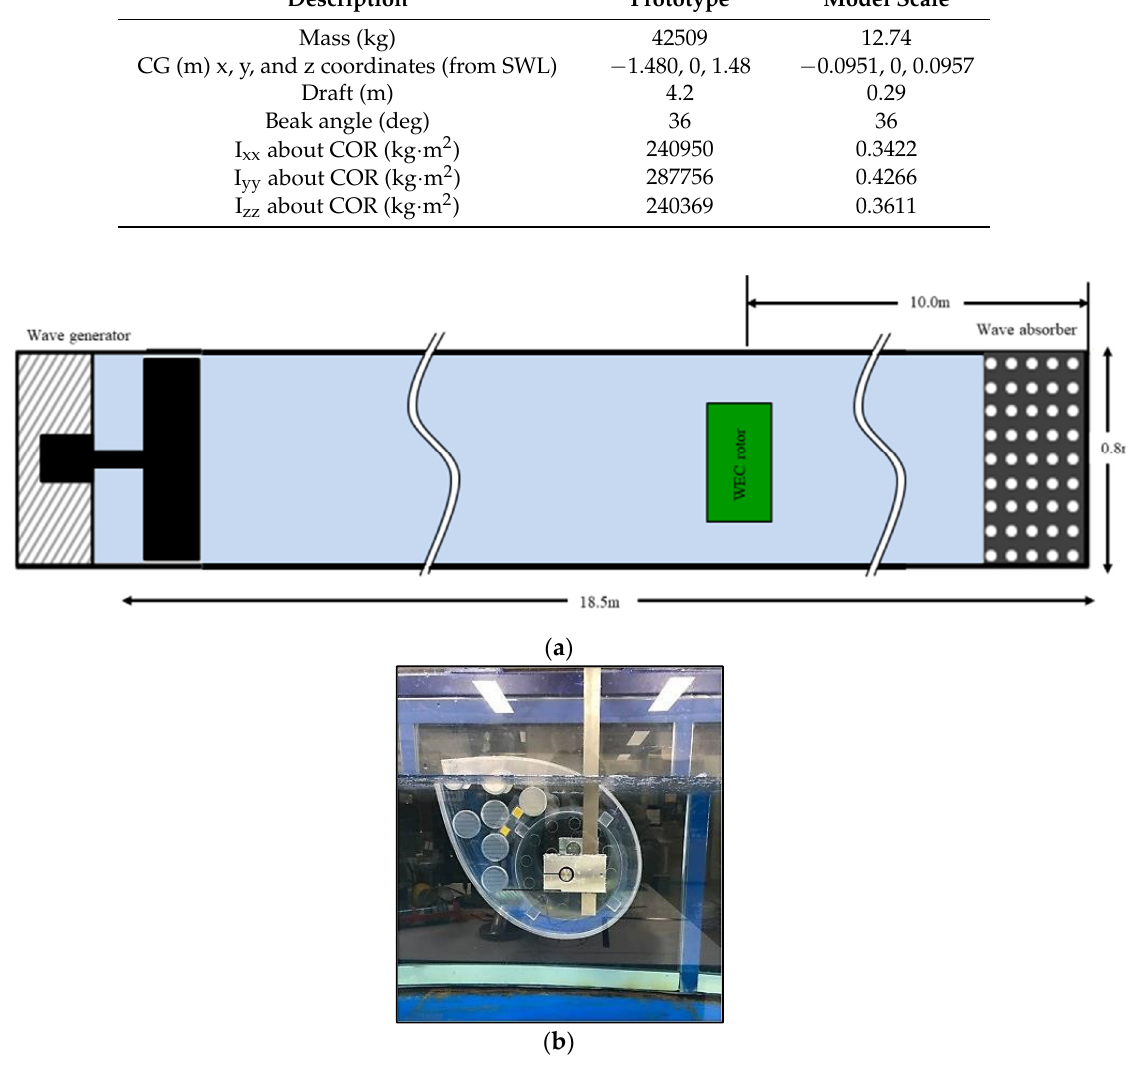
Figure 3. ( a ) Schematic diagram of the WEC rotor in the wave flume. ( b ) Experimental setup of the WEC rotor model in a flume.